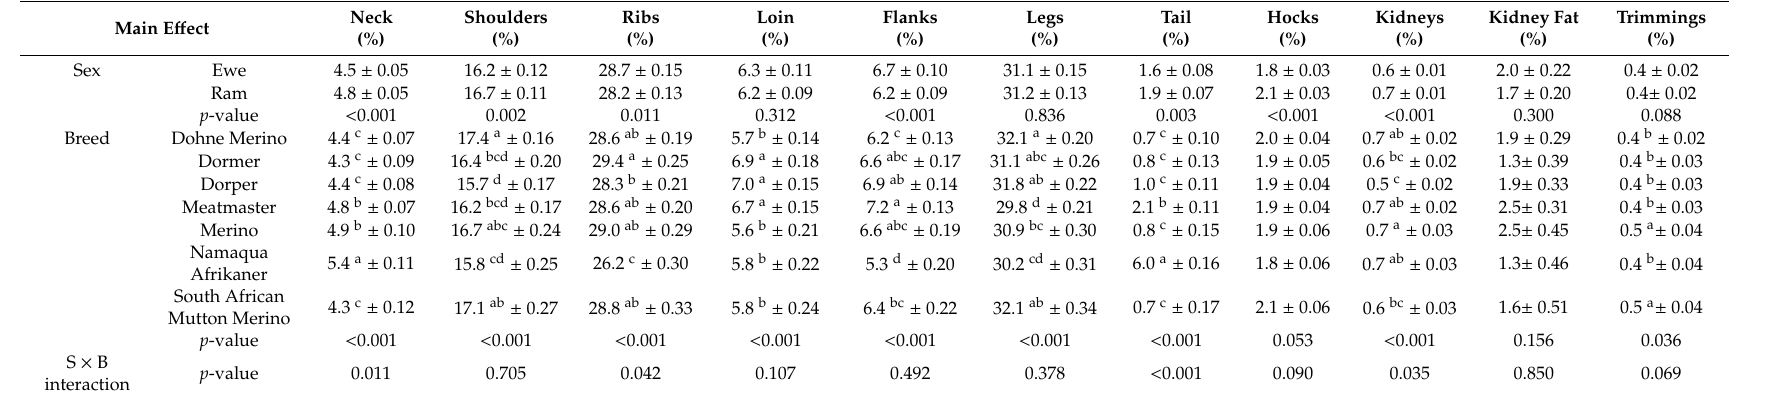
Table 5. Primal retail cut yields (as a proportion of cold carcass weight) of A2 carcasses, depending on the e ff ect of lamb sex and breed, expressed as the least square means ± standard